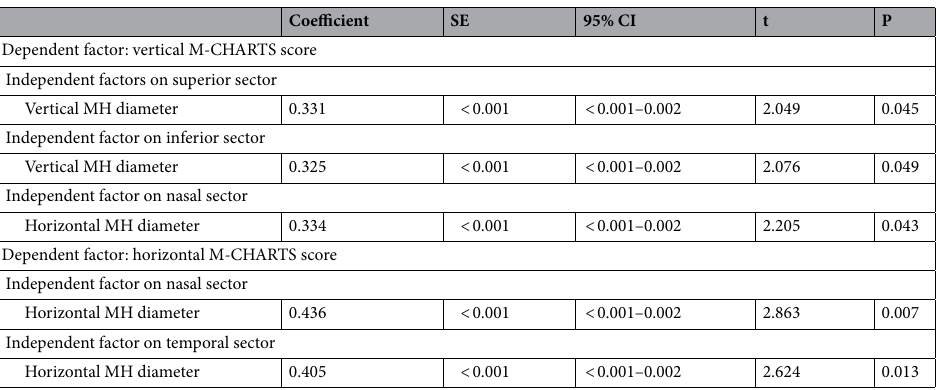
Table 5. Multivariate regression analysis for M-CHARTS score at 6 months after surgery. Independent factors: age, sex, INL%, OR%, RD%, MH diameter. The INL%, OR% and RD% for the nasal, temporal, superior and inferior sectors were selected respectively. Horizontal MH diameter was selected for the nasal and temporal sectors and vertical MH diameter was selected for the superior and inferior sectors. INL% and OR% were defined as the rate of change before and after surgery in INL and OR thicknesses measured in four sections of the macula: nasal, temporal, superior, and inferior, at 1000 μm away from the center of the fovea. SE standard error, CI confidence Interval, MH macular hole, INL % the rate of change in inner nuclear layer thickness, OR % the rate of change in outer retinal layer thickness, RD % the rate of change in retinal